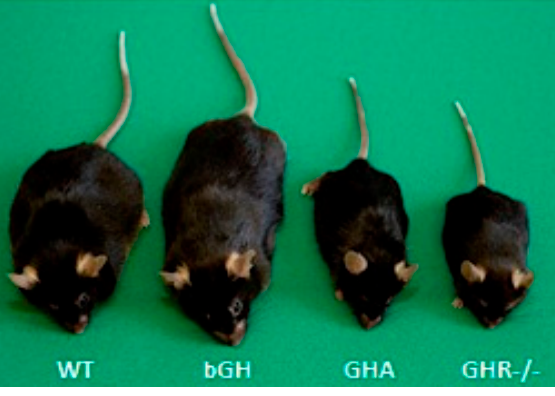
Figure 2. Mice with altered GH action. From left to right: a wild-type mouse, a bGH mouse with increased GH action, a GHA mouse with decreased GH action and a GHR-/- mouse with GH insensitivity. Adapted with permission from [36,37]. Copyright 2011 Elsevier.